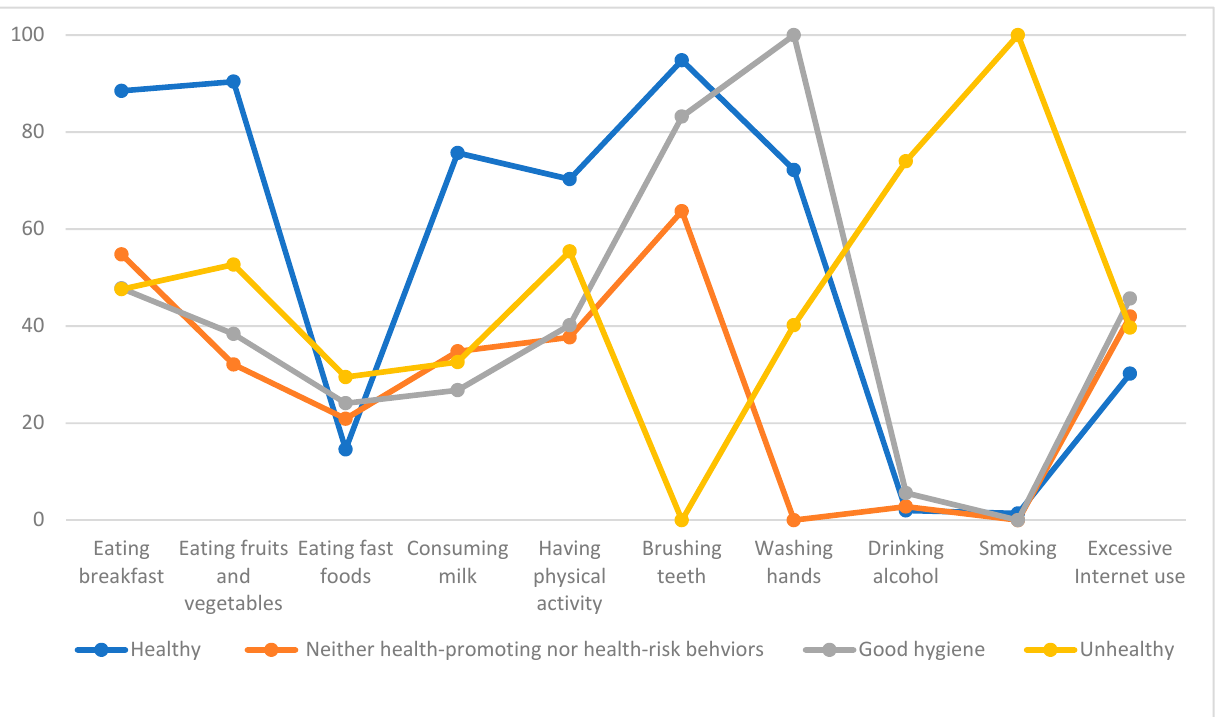
Figure 1. Health-related behavioral characteristics of each class among male adolescents .